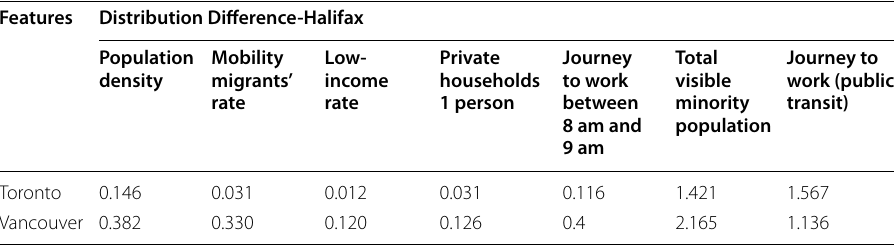
Table 4 KL-divergence between Halifax and the two source domains